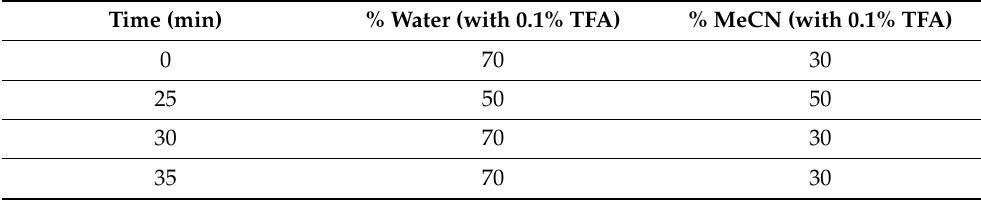
Table 3. HPLC Procedure for N-Oxides. The parameters below were used to purify N-Oxide S-MGBs using a flow rate of 6 mL/min. Time (min) % Water (with 0.1%